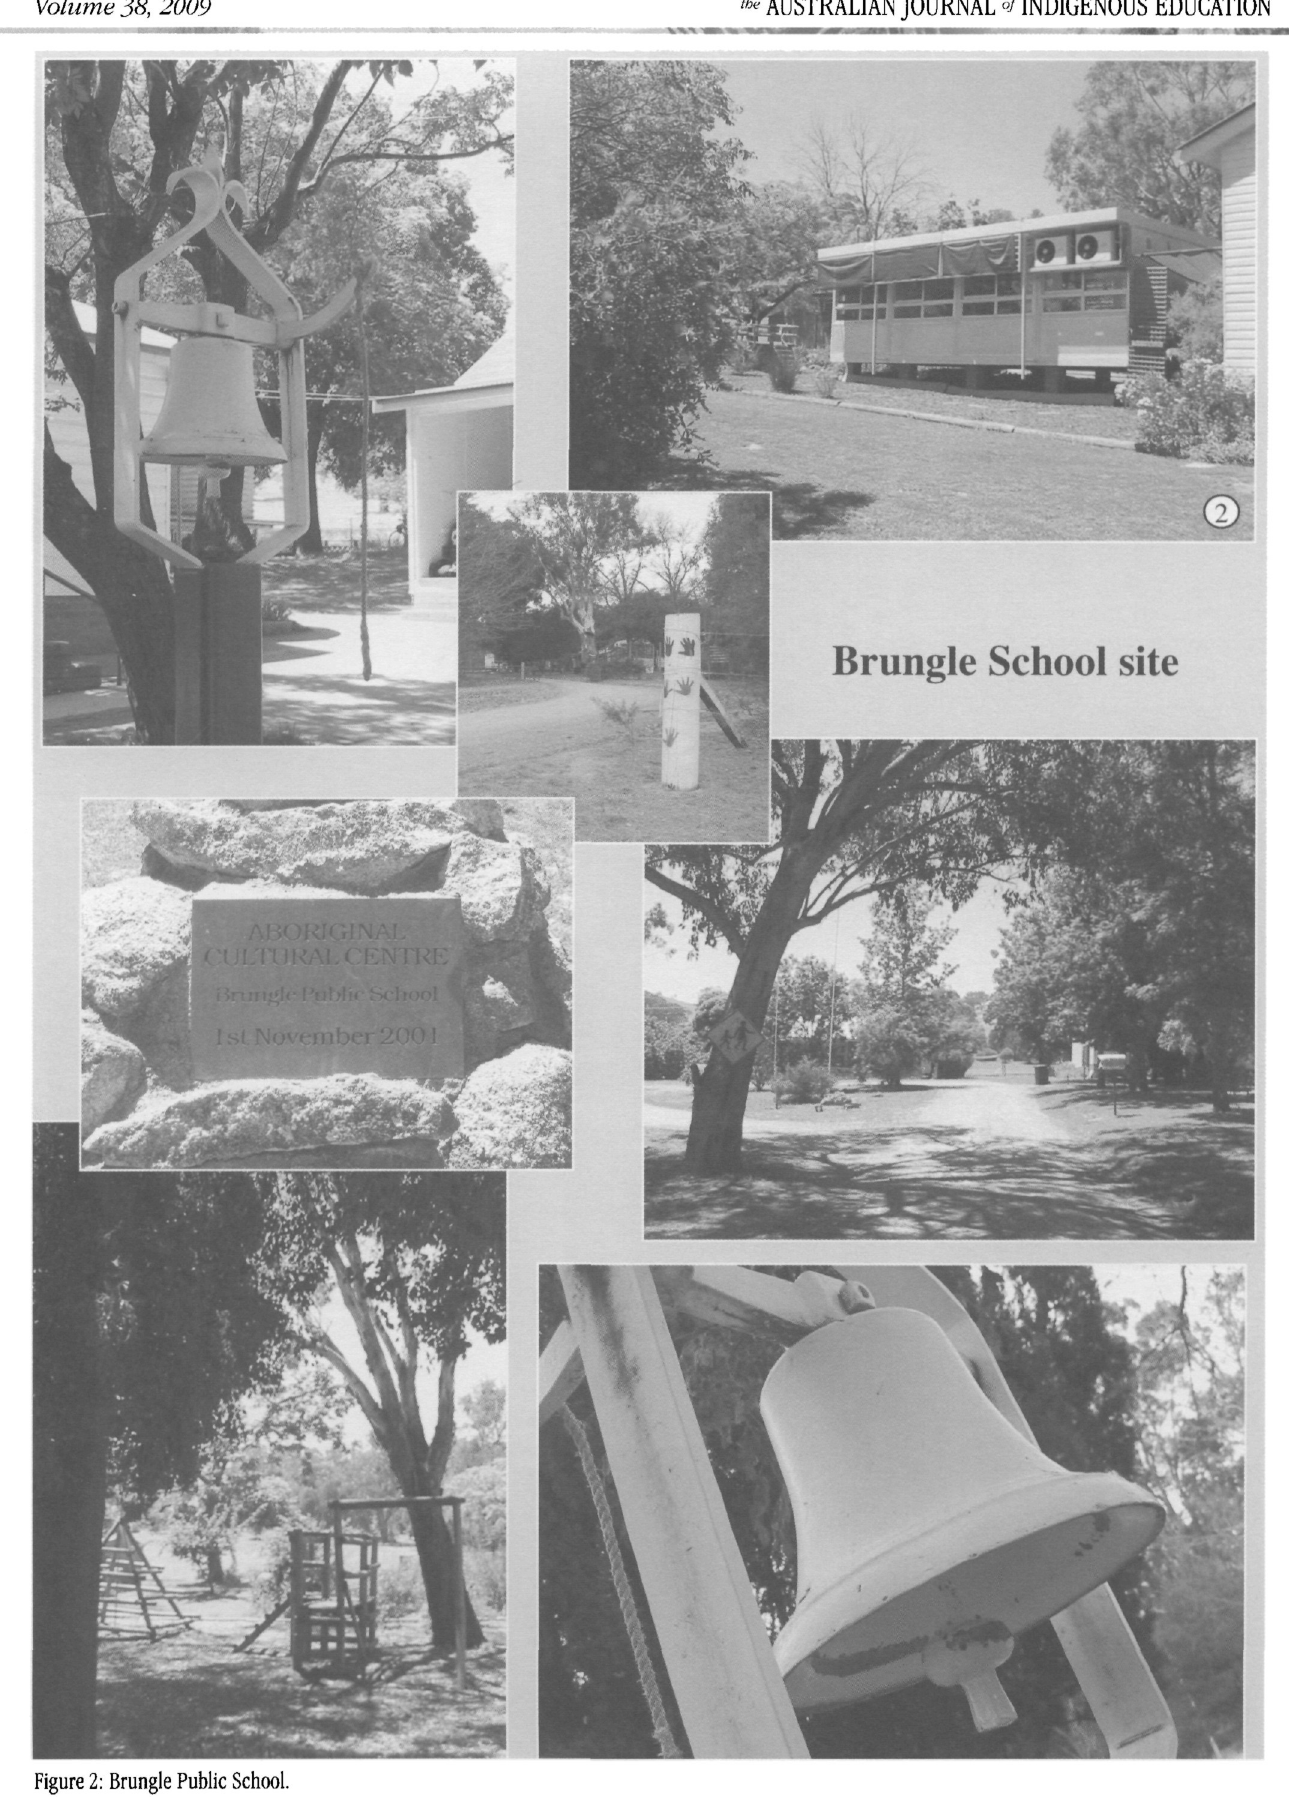
Figure 2: Brungle Public